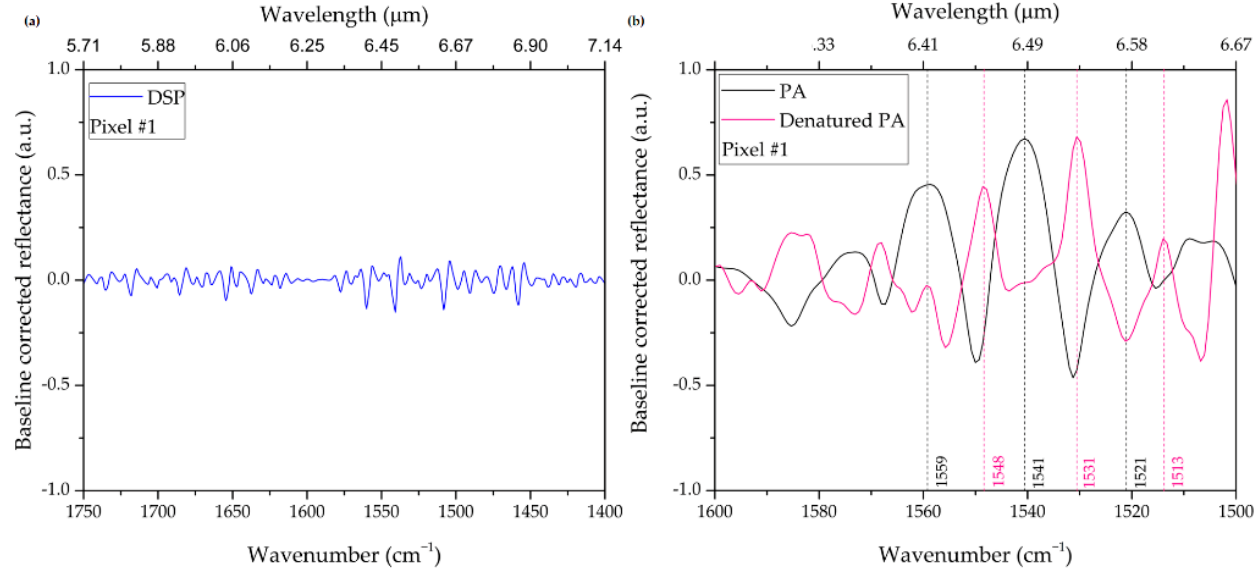
Figure 8. Baseline-corrected reflectance SEIRA spectrum pertaining to Pixel #1. ( a ) NAs functionalized with DSP molecules. ( b ) NAs with dehydrated monolayer of PA in the native (black curve) and denatured (purple curve) states.